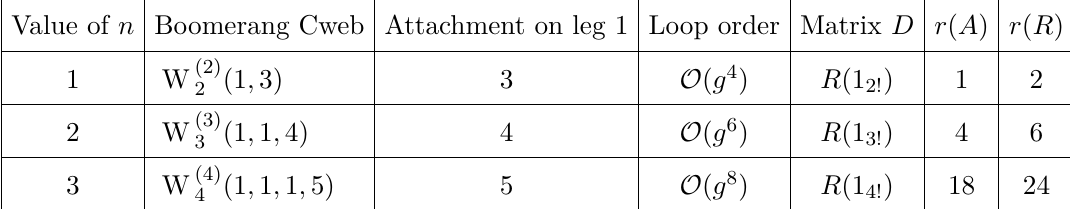
Table 2. Ranks of mixing matrices for Cweb W ( n +1)